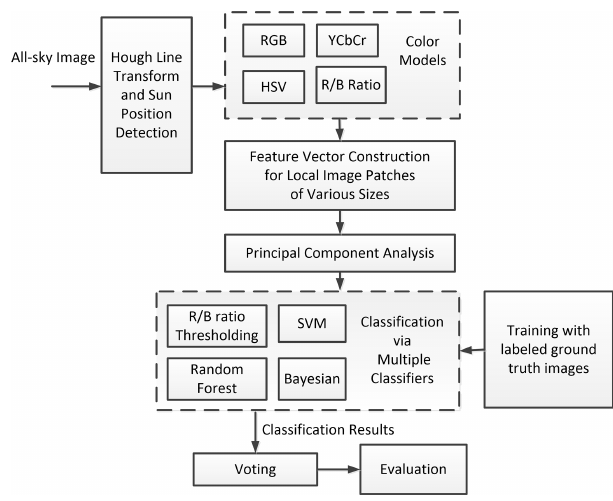
Figure 1. System